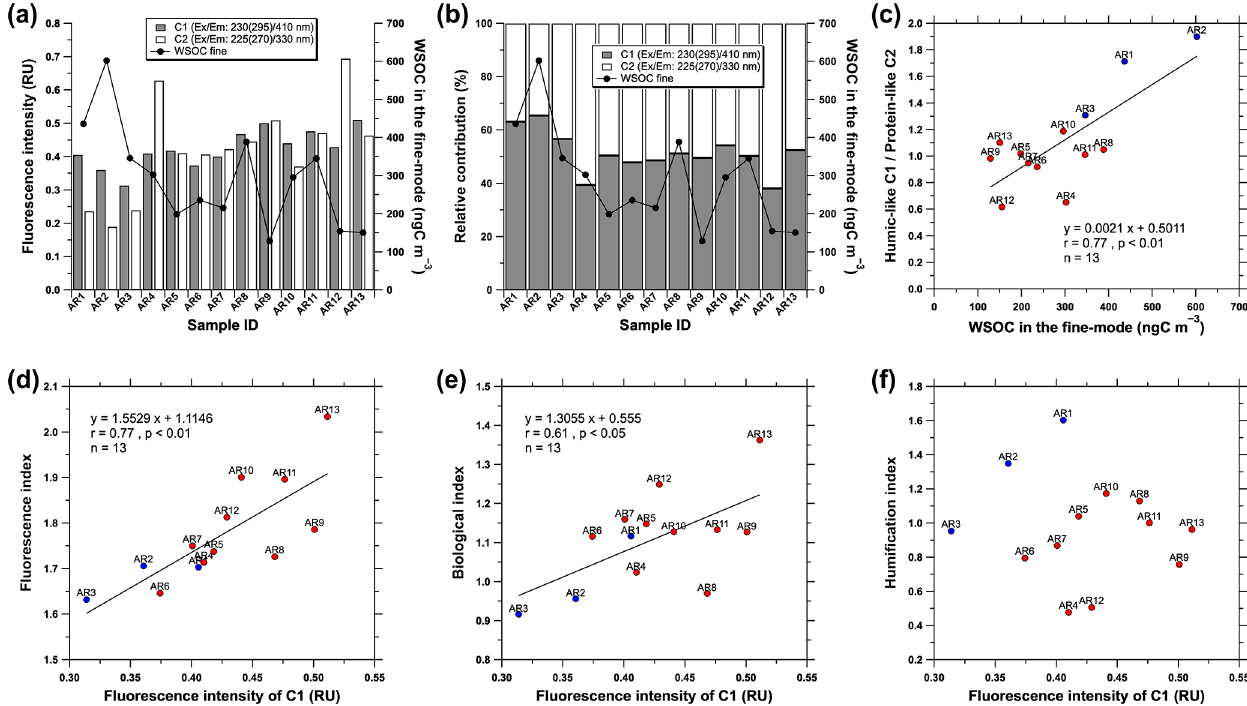
Figure 7. (a) Variations in the fluorescence intensities and (b) relative contributions of C1 and C2 in the fine-mode aerosols collected over the western Arctic Ocean during the summer of 2016. The black lines with circles in (a) and (b) indicate the WSOC concentration in the fine- mode aerosols. (c) Relationship between the fluorescence intensity ratio of the humic-like C1 / protein-like C2 and the WSOC concentration in the fine-mode aerosol particles. (d) Fluorescence index (FI), (e) biological index (BIX), and (f) humification index (HIX) as a function of the fluorescence intensity of the humic-like C1 in the fine-mode aerosols. The solid blue and red circles in (c–f) indicate the samples collected from the coastal and sea-ice-covered areas,